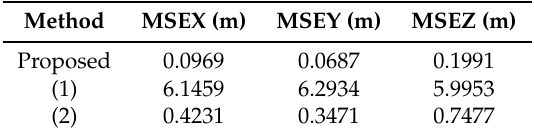
Table 6. Total Mean Squared Error of the estimated position of landmarks.